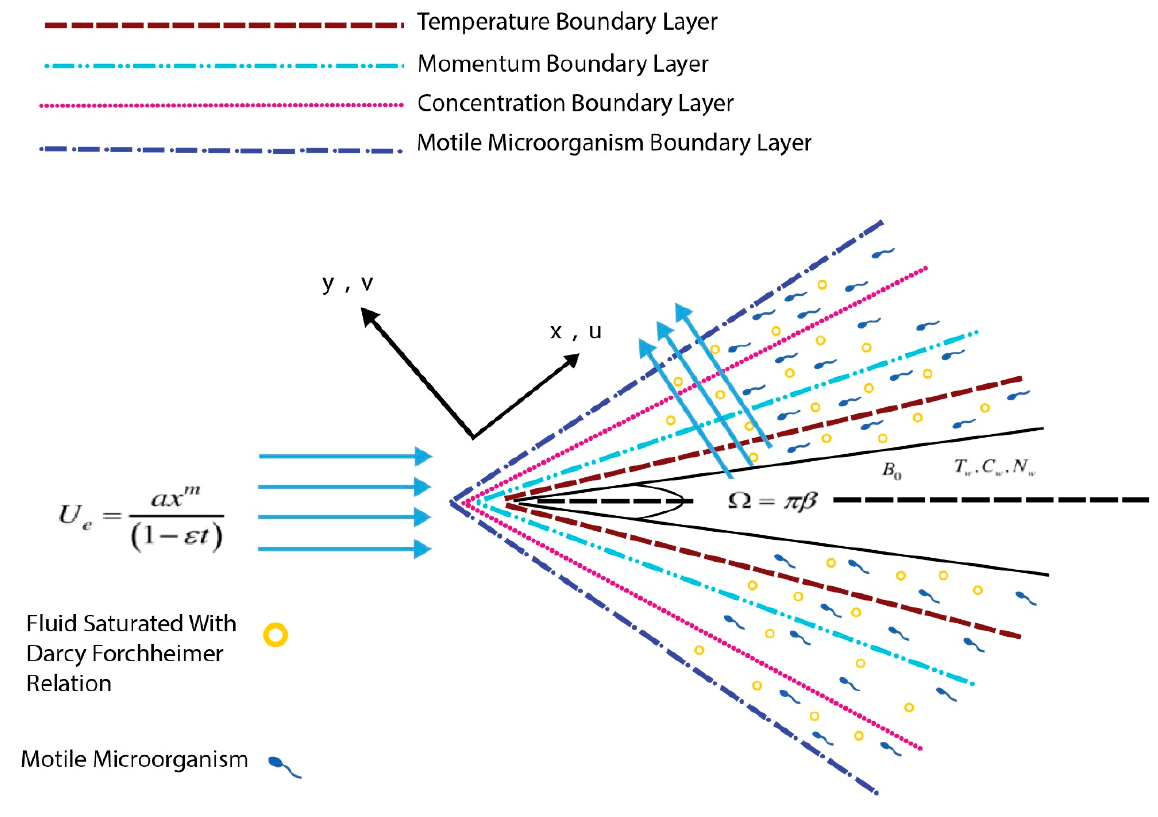
Figure 1. Schematic structure.